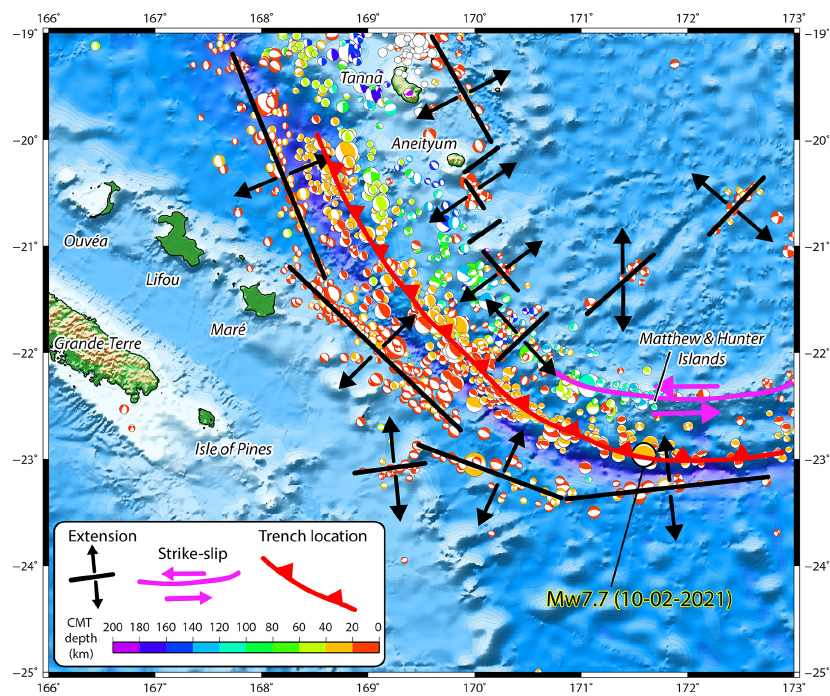
Figure 2. Focal mechanisms from the Global Centroid Moment Tensor (GCMT) project in the southern part of the Vanuatu subduction zone and geodynamical